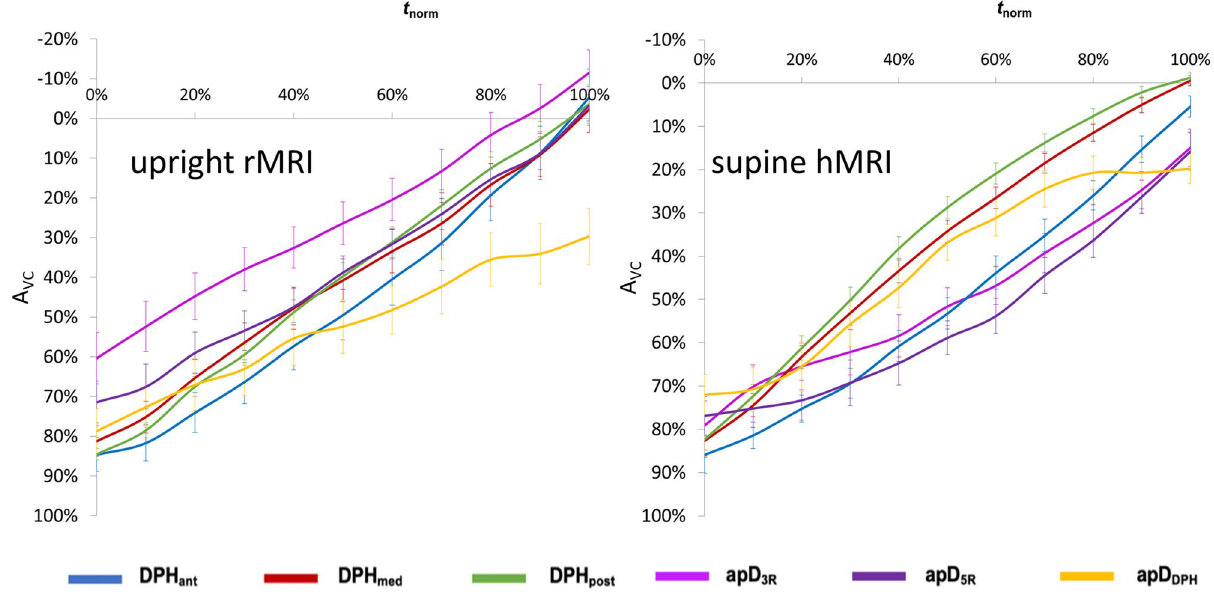
Figure 7. Thoracic movements during phonation take place at 20% higher vital capacity range in supine position. Upright rMRI data is displayed on the left, supine hMRI data on the right. Normalized curve amplitude according to individual maximum inspiration and expiration (AVC) is displayed on y-axis and normalized time (t norm ) is displayed on x-axis. Different locations are displayed in different